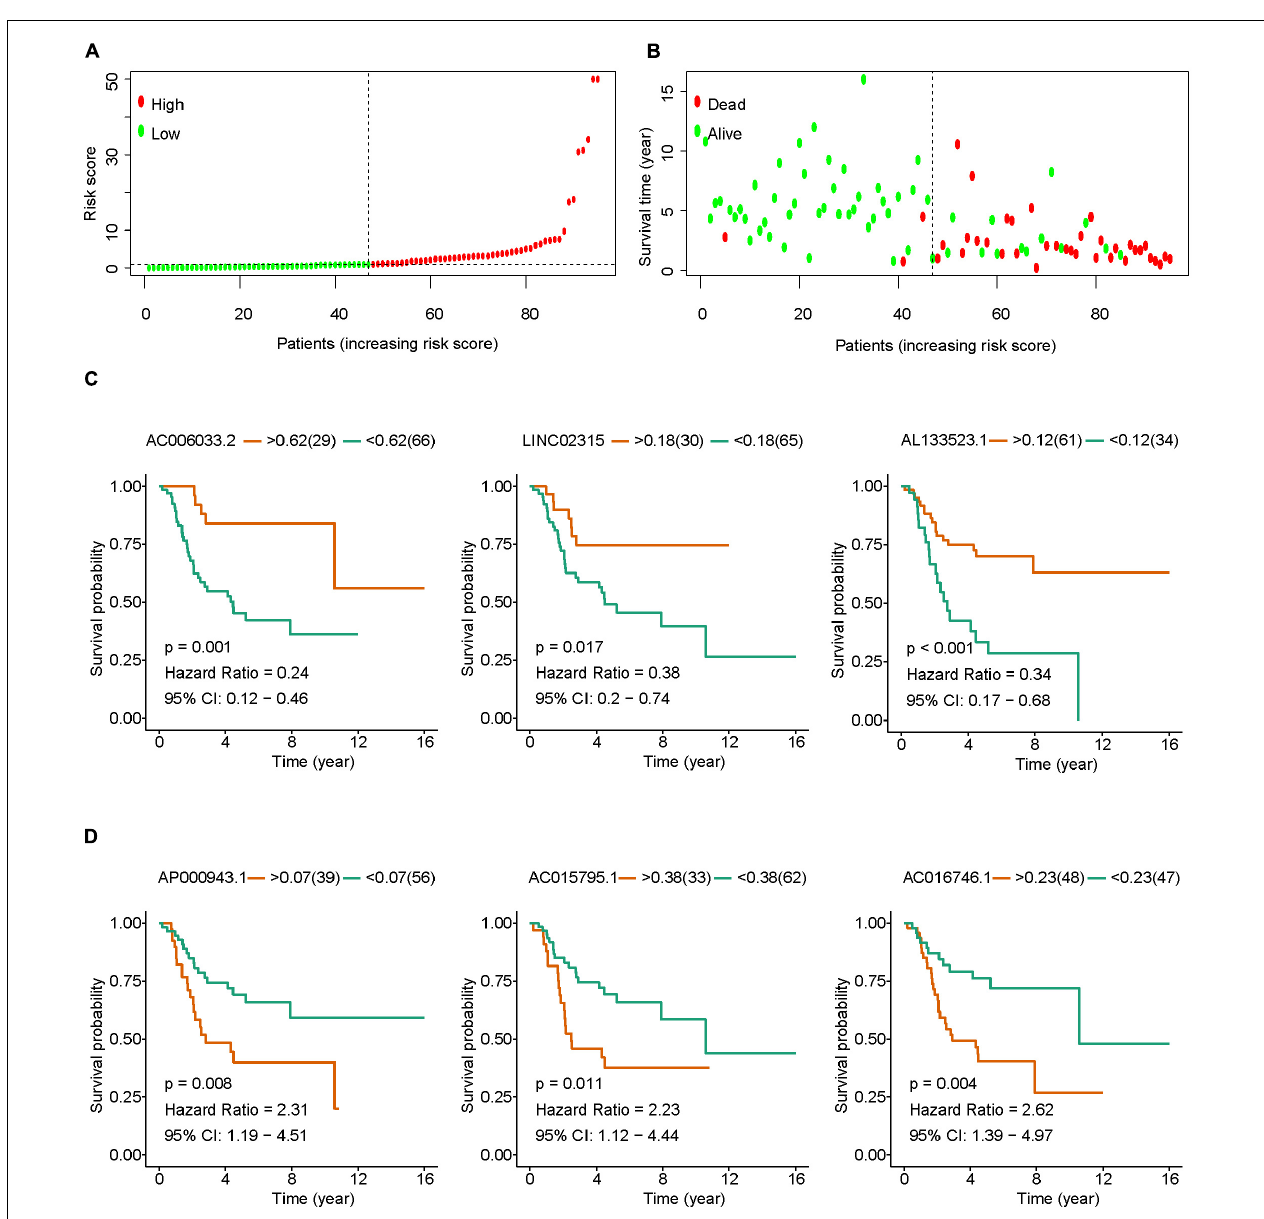
FIGURE 2 | The role of IRLs signature in the prognosis of osteosarcoma. (A) Osteosarcoma was divided into high-risk group and low-risk group according to the optimal cut-off value of risk score. (B) Relationship between risk score and survival states in patients with osteosarcoma. (C,D) Osteosarcomas were grouped according to the optimal cut-off value of lncRNAs expression in IRLs signature, and survival analysis was